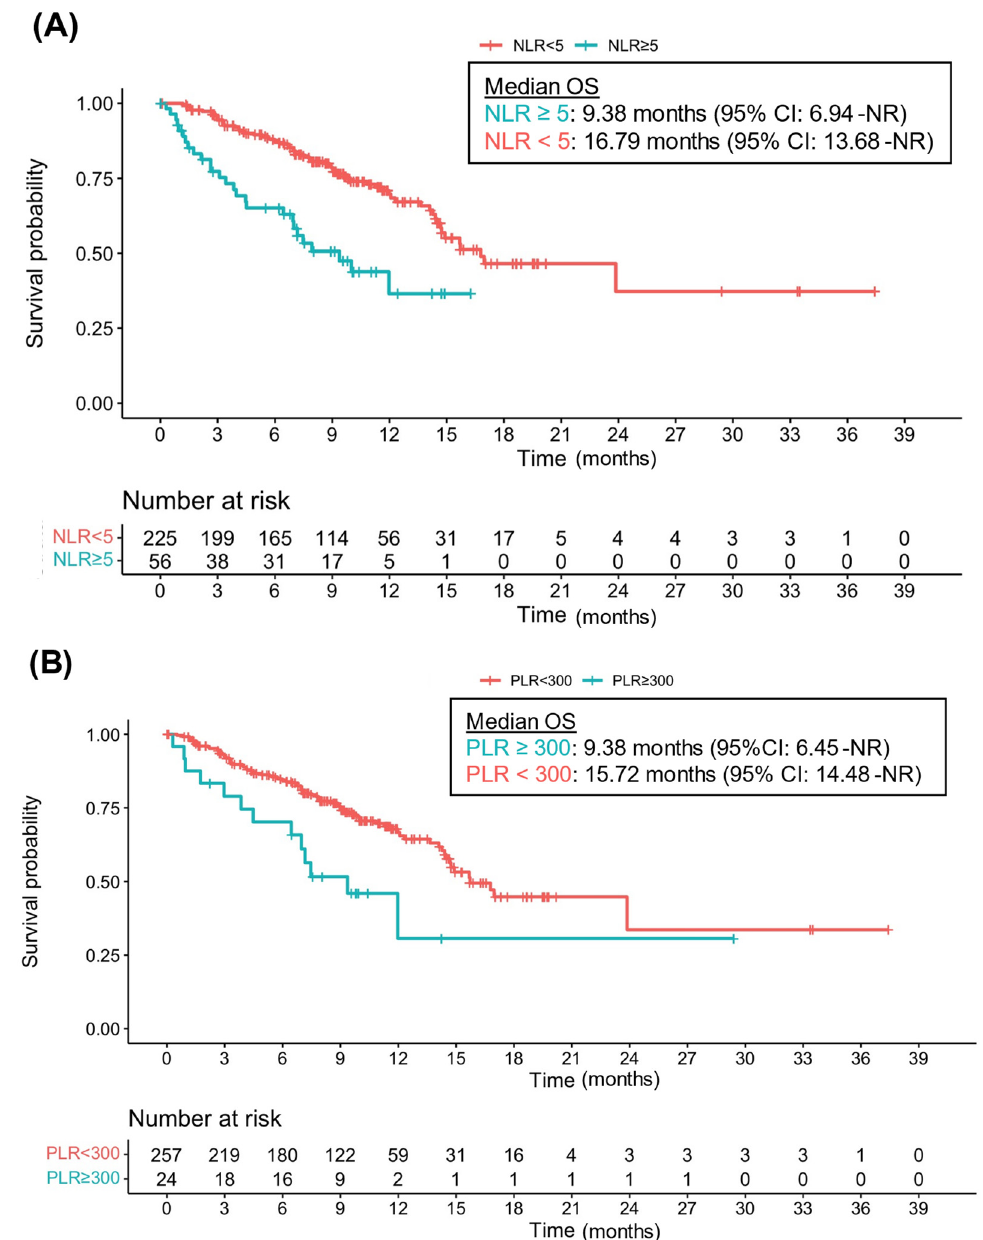
Figure 1. Kaplan–Meier curves for overall survival (OS) according to neutrophil-to-lymphocyte ratio (NLR) and platelet-to-lymphocyte ratio (PLR) status: ( A ) OS according to NLR; ( B ) OS according to PLR.